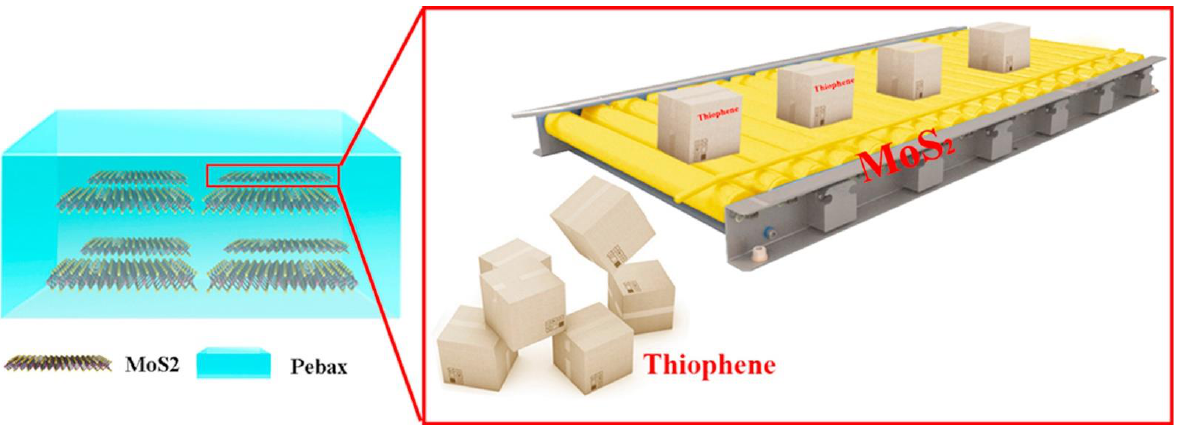
Figure 3. Scheme of an MMM comprising MoS 2 2D nanosheets that create a continuous facilitated transport pathway for thiophene (from ref. [32]).